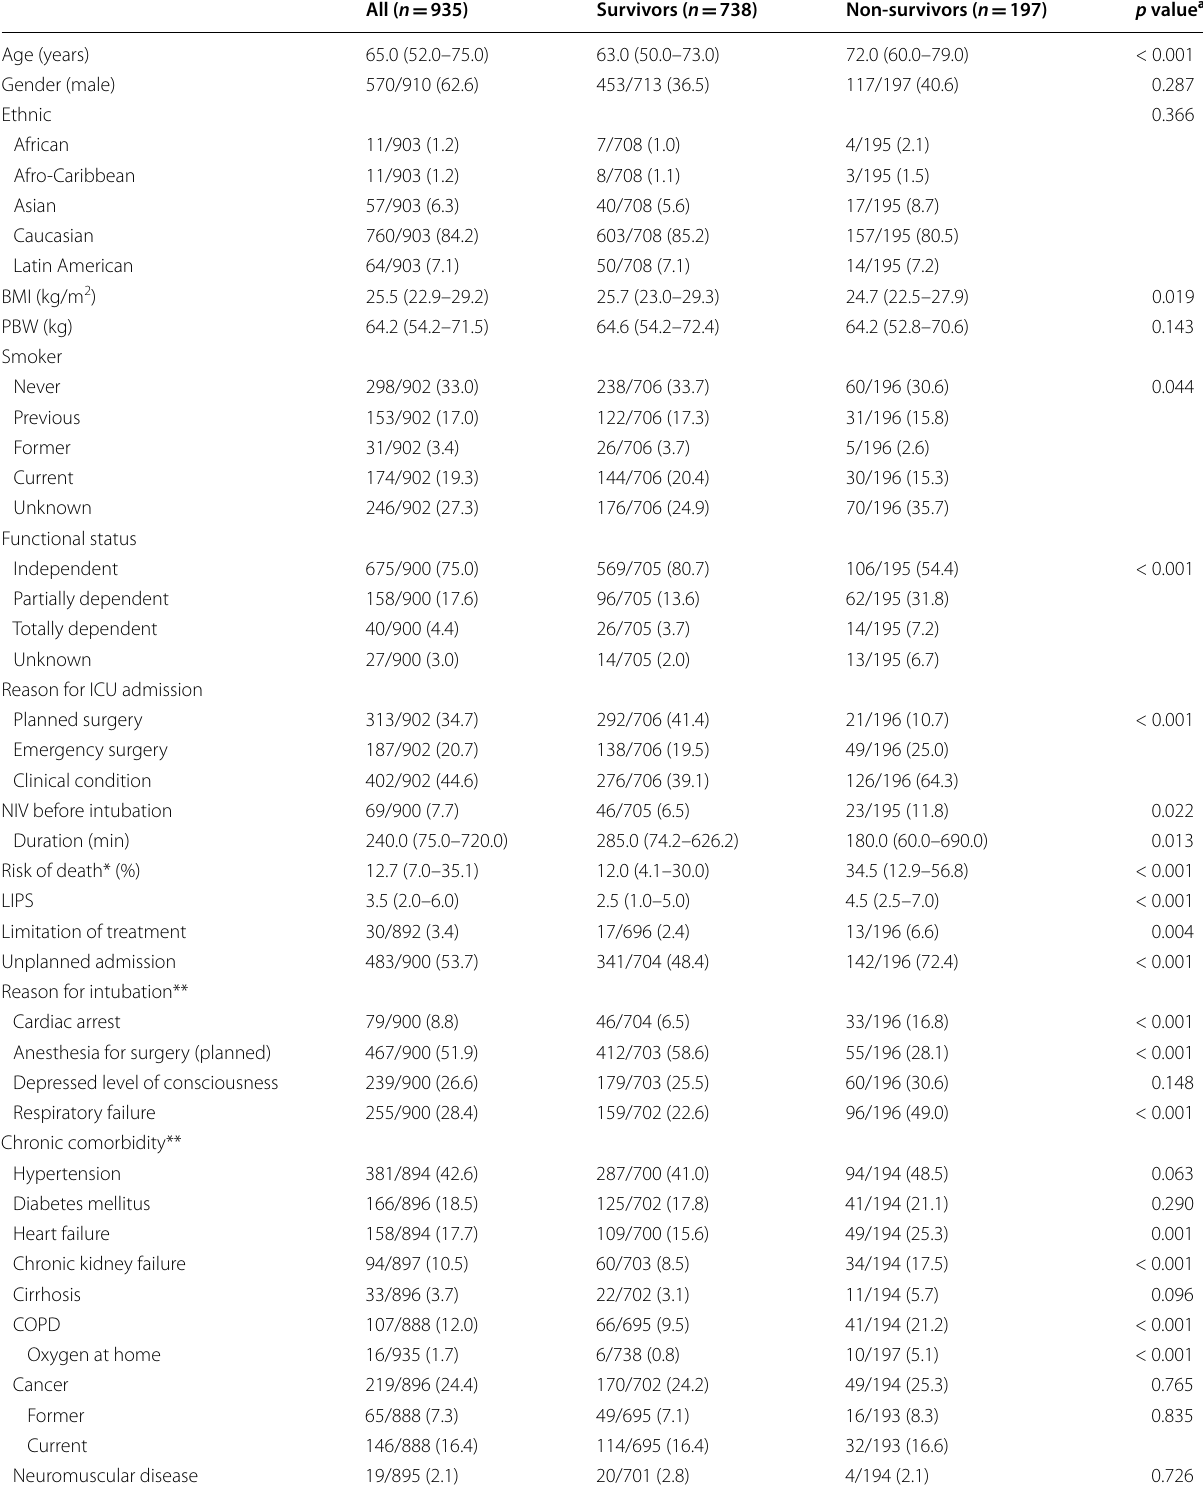
Table 1 Demographic characteristics of patients without ARDS receiving mechanical ventilation, comparison of